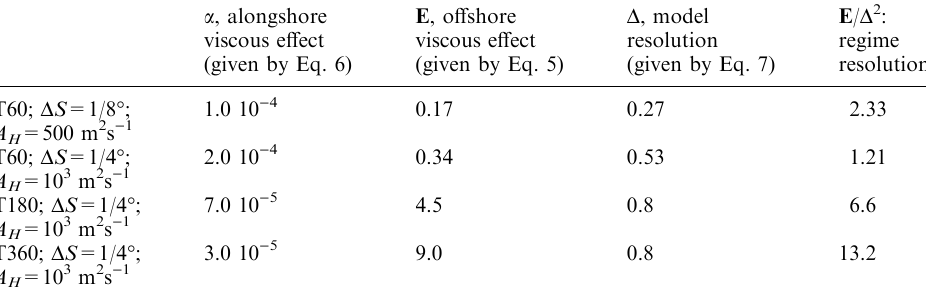
a , alongshore viscous e(cid:128)ect (given by Eq. 6)